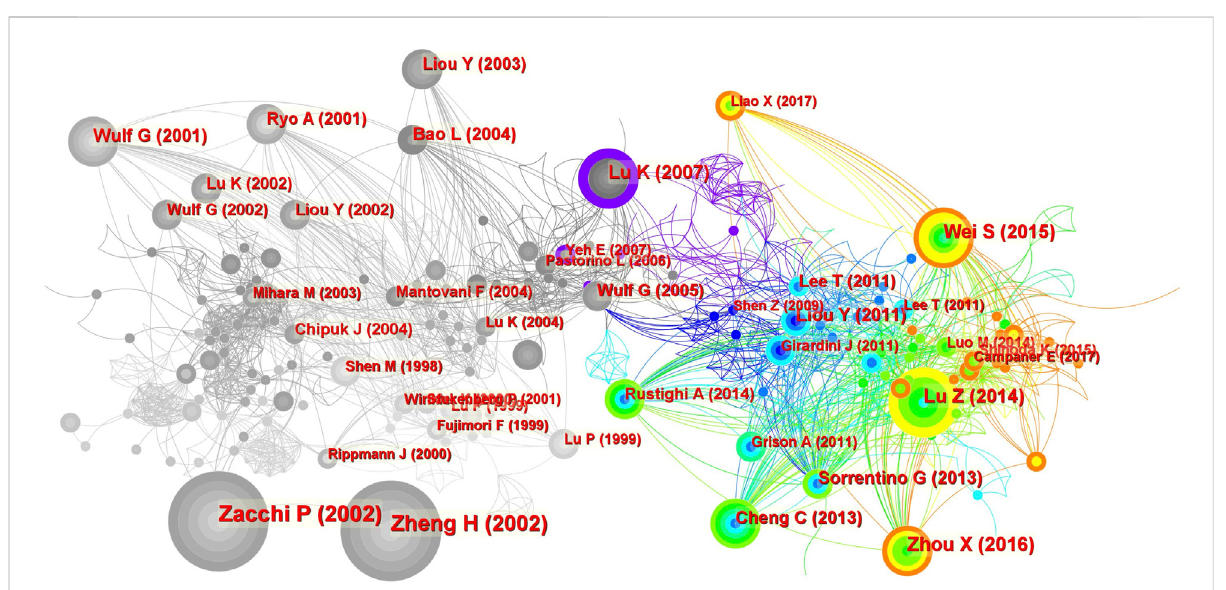
FIGURE 9 Co-citation analysis of references. The size of the circle represents the number of co-citations. The color of the circle represents the publication time of the co-cited literature, and the color of the outer circle represents the centrality of the